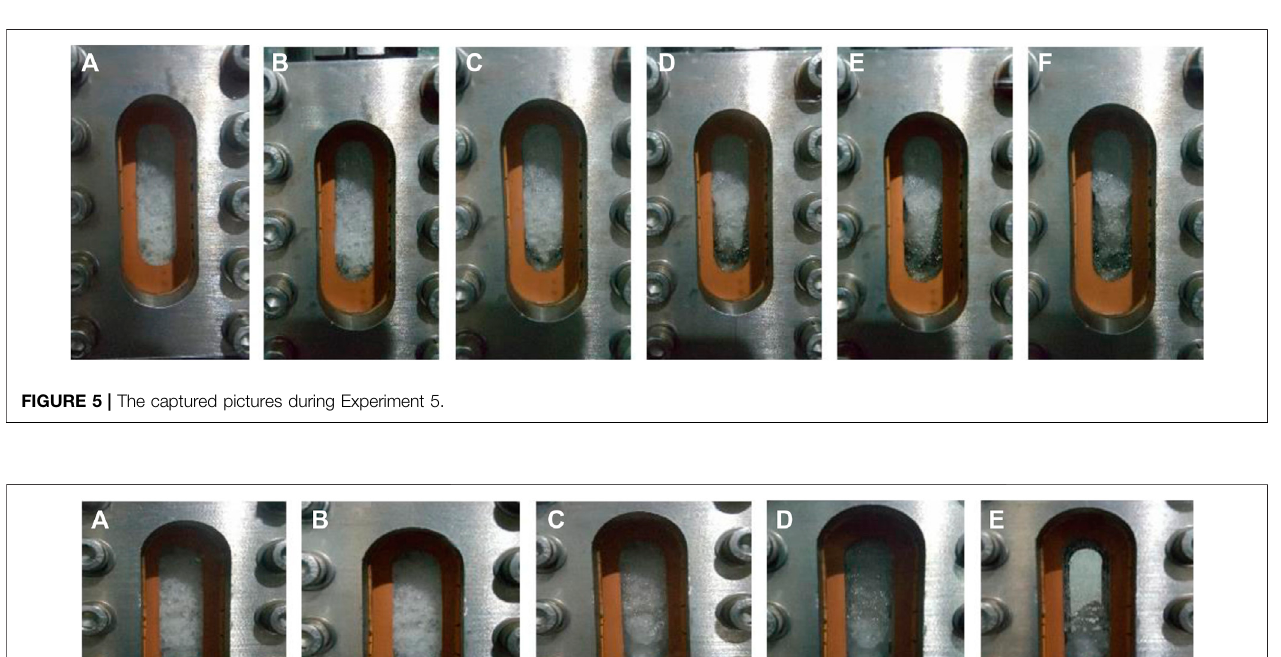
Frontiers in Energy Research |